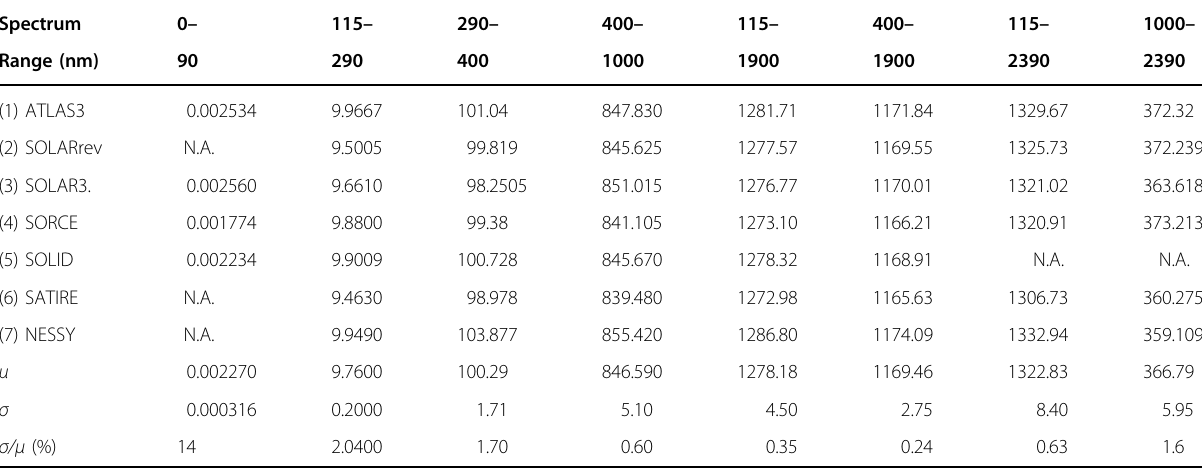
Table 3 Power in Wm − 2 per spectral domains Spectrum